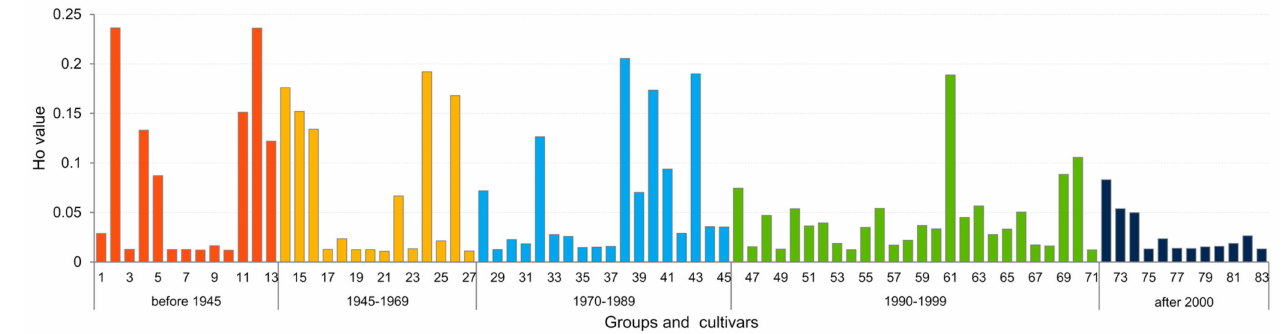
Figure 6. Heterogeneity level of 83 spring barley cultivars expressed by observed heterozygosity value based on SNPs derived from DArTseq analysis.